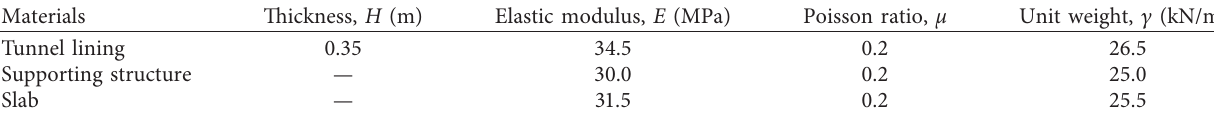
Table 3: Physical and mechanical parameters of the materials.